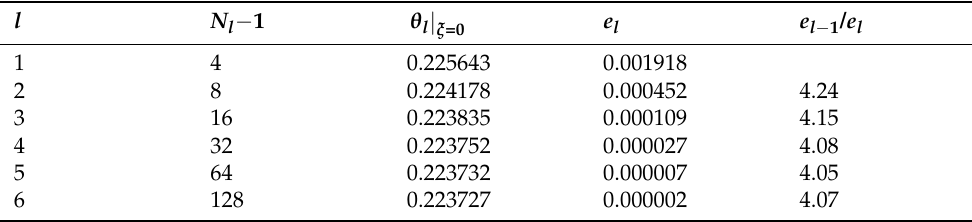
Table 2. Approximation 𝜃 𝑙 | 𝜉=0 of the temperature on the liquid–solid surface at time 𝜏 = 1 and the corresponding error 𝑒 𝑙 for different number of space mesh-points 𝑁 𝑙 .